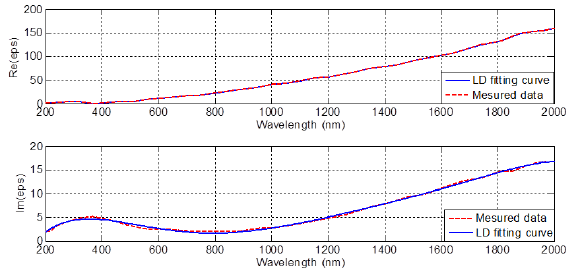
Figure 3. LD fitting curves for the real and the imaginary parts of the Au permittivity using experimental data in [3].